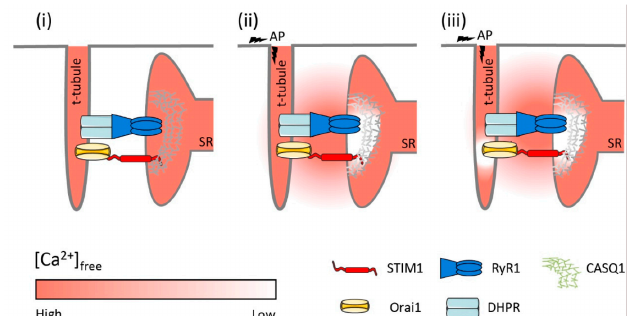
Figure 4. Proposed model of pSOCE activation following AP-evoked Ca 2+ release in skeletal muscle. ( i ) At rest, some STIM1–Orai1 complexes are prearranged at the junctional membranes close to the position of the RyRs. ( ii ) During AP-evoked Ca 2+ release from the SR, Ca 2+ depletion within the SR occurs locally and is restricted to a nanodomain behind the RyR channels, which are presumably shaped by the network of CASQ. ( iii ) The local depletion of Ca 2+ in a spatially restricted domain behind the RyRs allows for rapid dissociation of Ca 2+ from STIM1 to activate SOCE. Under resting conditions, free [Ca 2+ ] SR was reported at about 0.5 mM in intact FDB fibers [115] and 0.31 mM in mouse tibialis anterior (TA) muscle [112]. In rat skinned